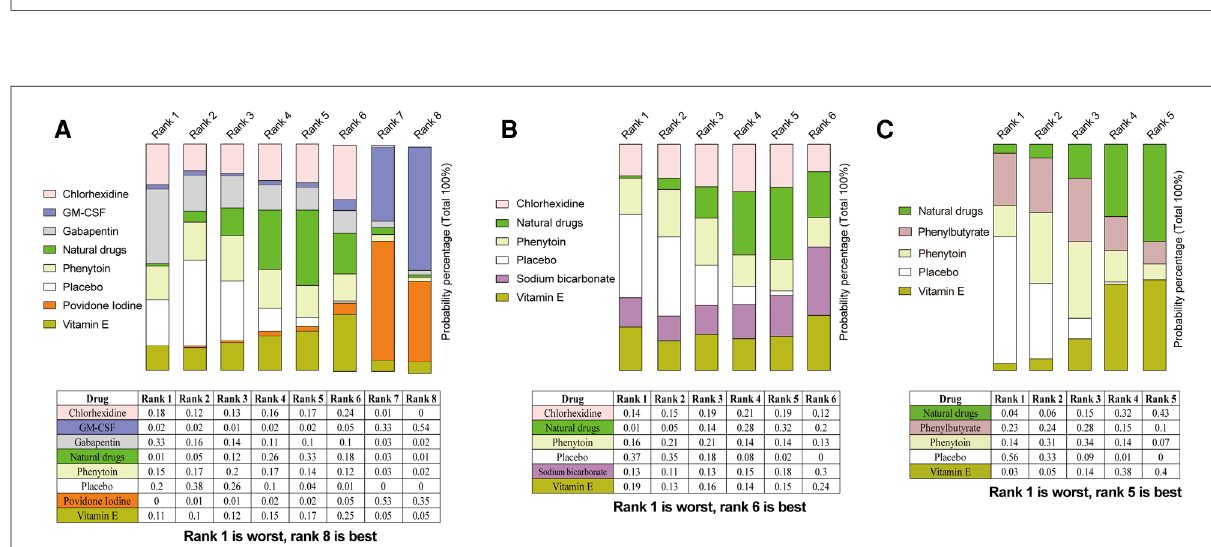
FIGURE 7 Ranking probabilities based on multiple comparisons for OM score improvement after treatment for one ( A ), two ( B ), and three ( C ) weeks. The total probability of a single histogram is 100%, and a larger band indicates a higher probability in this ranking. The worst effect was Rank 1 and the best, Rank 8. Abbreviations: GM-CSF, granulocyte-macrophage colony-stimulating factor. Note: Natural drugs in Figure A include Achillea extract, Althaea root extract, Plantago major extract, Curcumin, and Royal jelly; in Figure B include Achillea extract, Althaea root extract, Plantago major extract, and Royal jelly; in Figure C include Achillea and